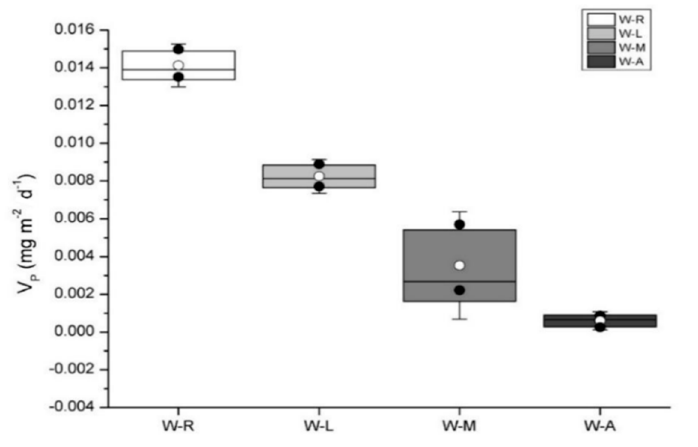
Figure 3. Variations of sediment phosphorus release rates in different wetlands.